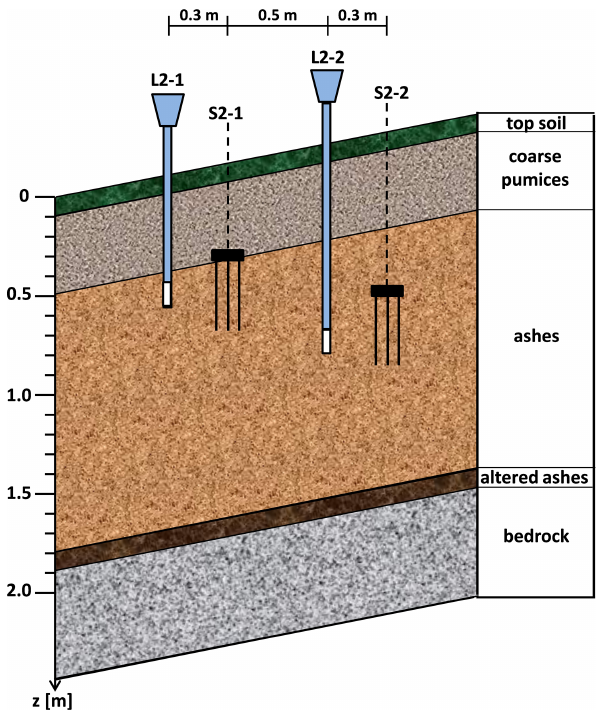
Table 1. Main physical and mechanical properties of the pyroclastic cover: specific unit weight, γ s ; unit weight, γ ; porosity; cohesion,